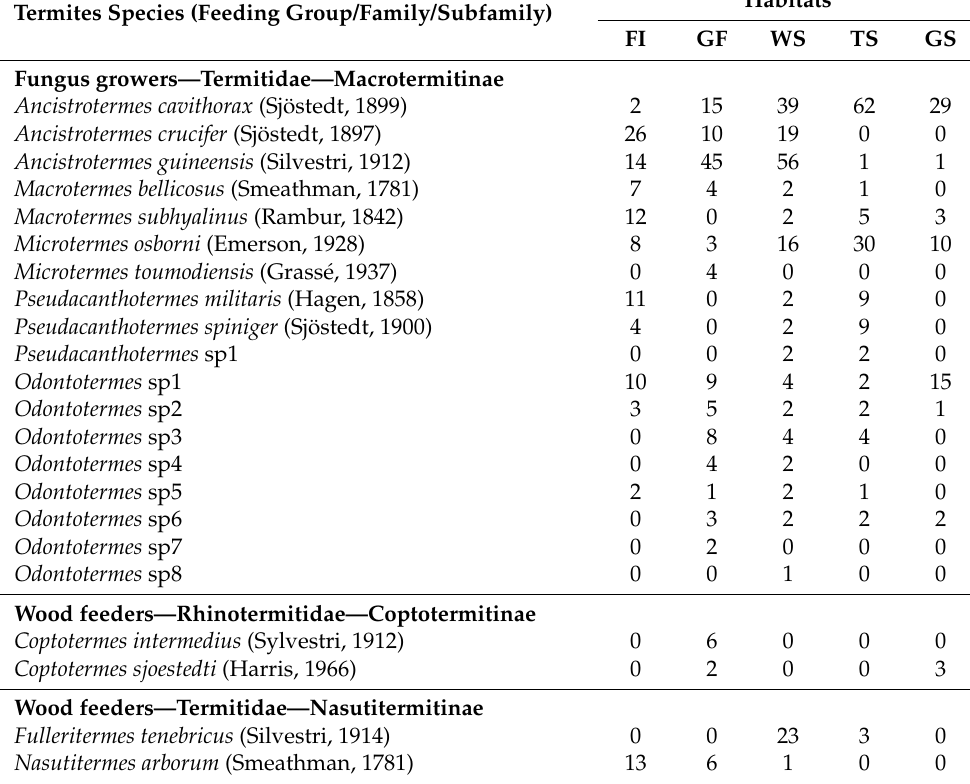
Table A1. List of species and morphospecies recorded in the visited habitats of the Comoe National